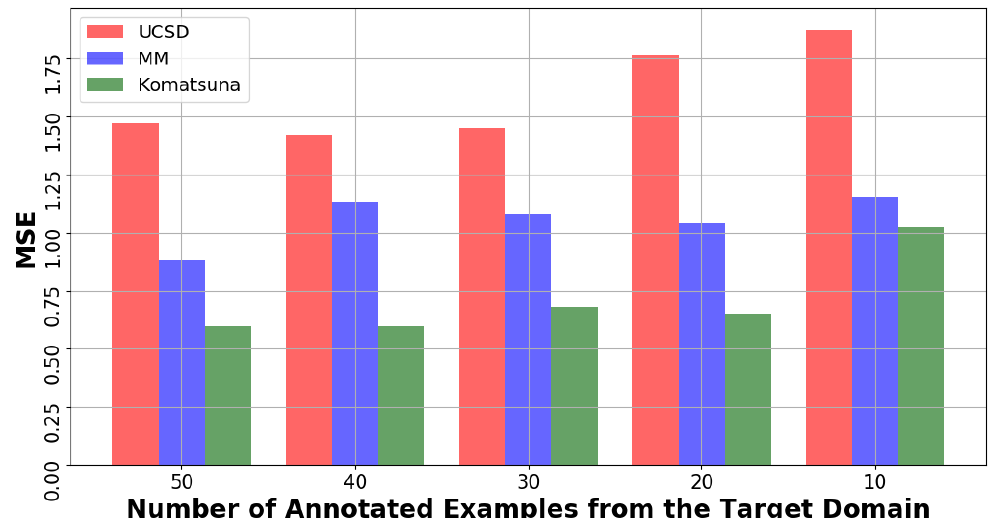
Figure 6. MSE variation during fine-tuning (cf. Section 3.3) wrt a decreasing number of annotated samples from the target